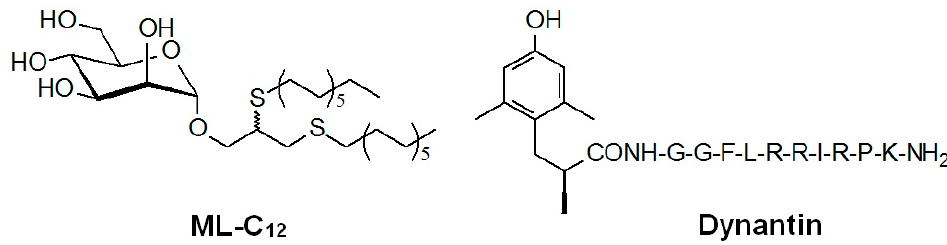
Figure 1. Structure of ML-C 12 and dynantin.